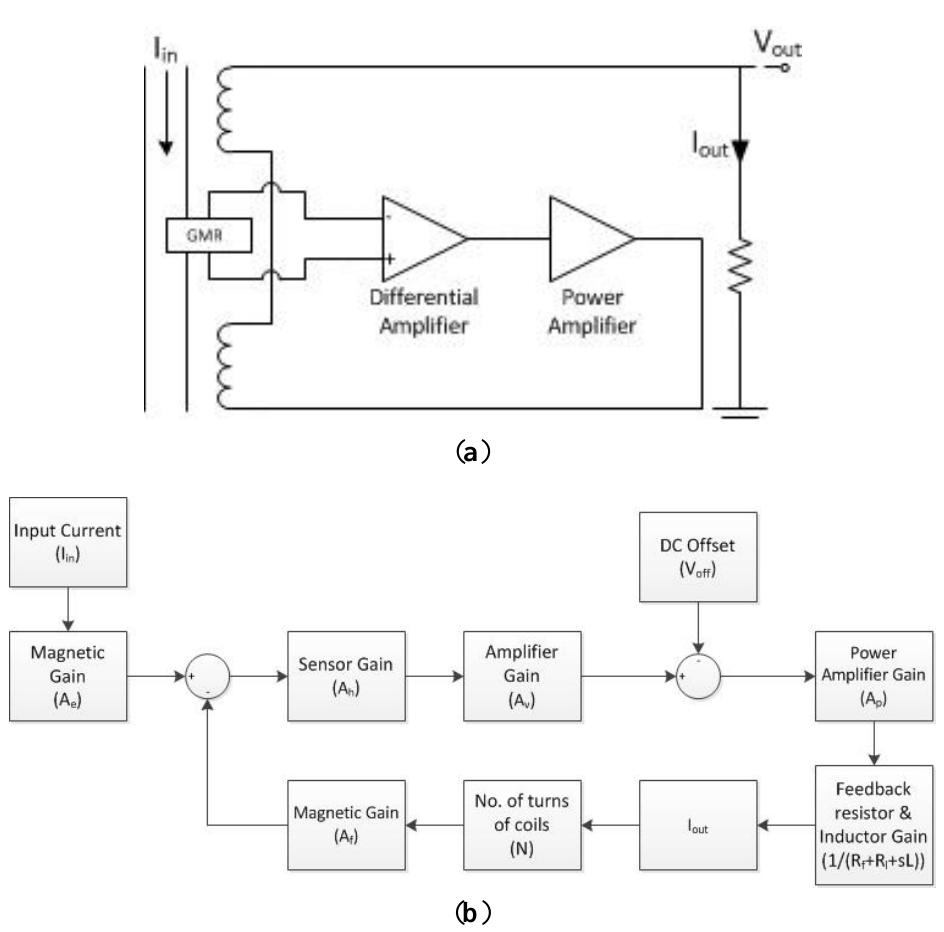
Figure 4. ( a ) Simplified circuit diagram; ( b ) block diagram of the